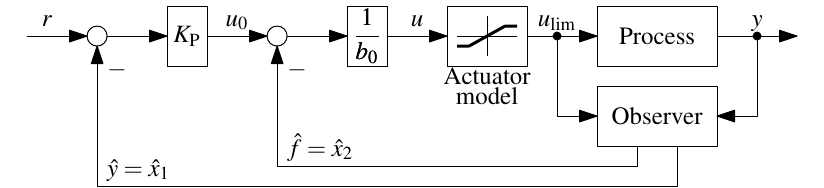
Figure 5. Control loop structure of first-order ADRC considering actuator saturation.